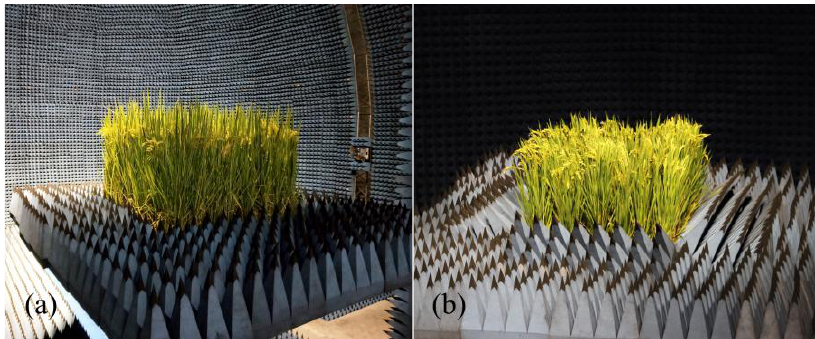
Figure 3. Rice field scenes measured in ( a ) 2019 and ( b ) 2021. Table 1. Layout parameters of two rice field scenes.